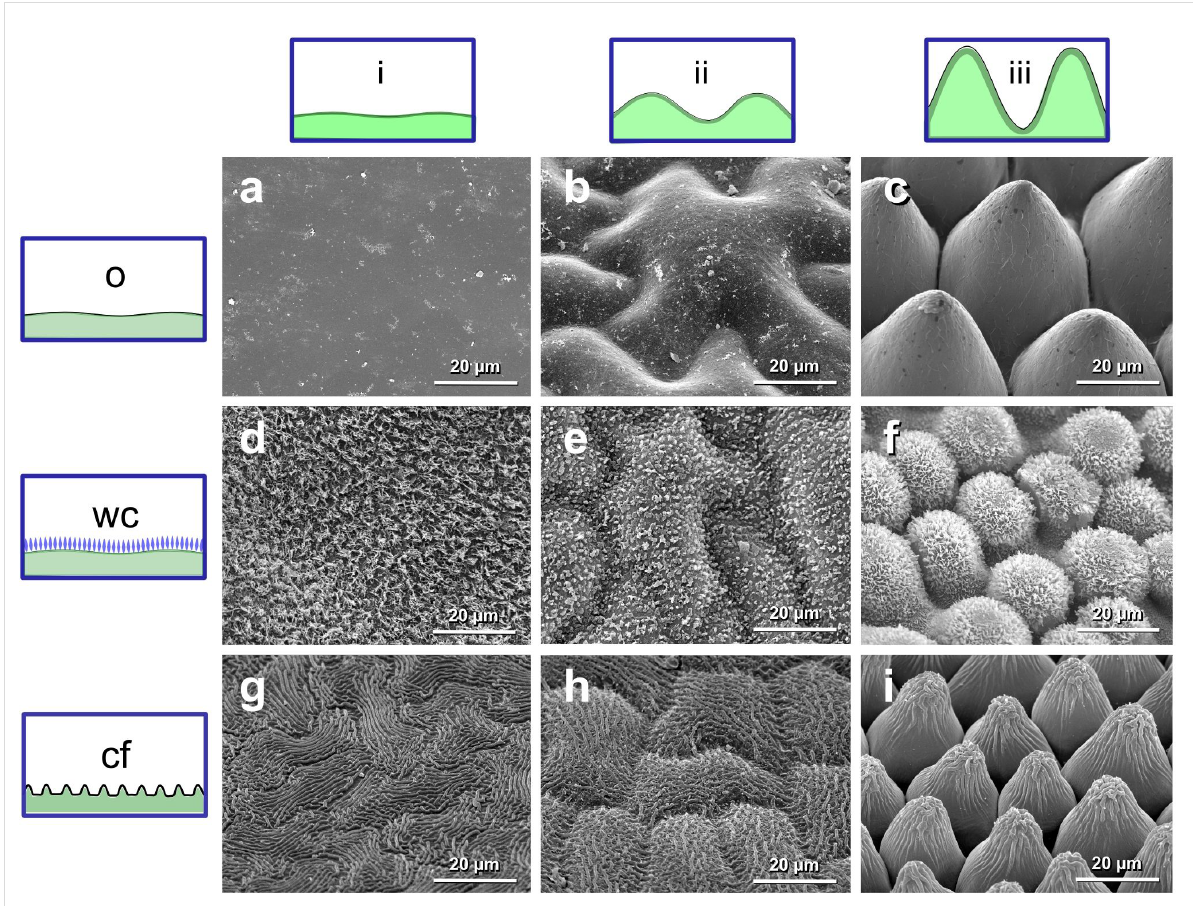
Figure 1: Plant surfaces investigated showing different types of structuring. Pictograms on the top show the shape of the epidermal cells: Tabular cells (i), convex cells (ii) and papillate cells (iii). Pictograms on the left illustrate the level of superimposed microstructuring: Films of wax / no further structuring (o), epicuticular wax crystals (wc) and cuticular folds (cf). SEM micrographs of plant surfaces: (a) Magnolia grandiflora , (b) Paeonia offi- cinalis , (c) Calathea zebrina , (d) Diospyros kaki , (e) Paeonia suffruticosa , (f) Colocasia esculenta , (g) Hevea brasiliensis , (h) Vitis vinifera , (i) Rosa hybrid Floribunda cv . “Sarabande”.